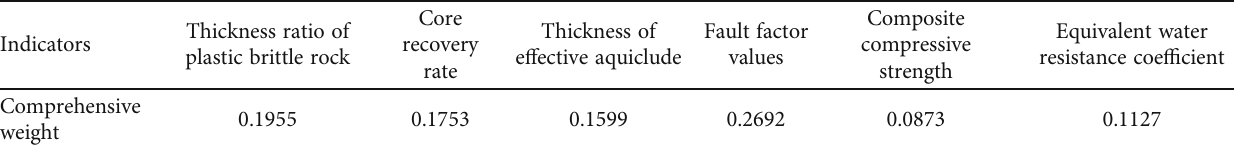
Table 9: Comprehensive weight of index factors.